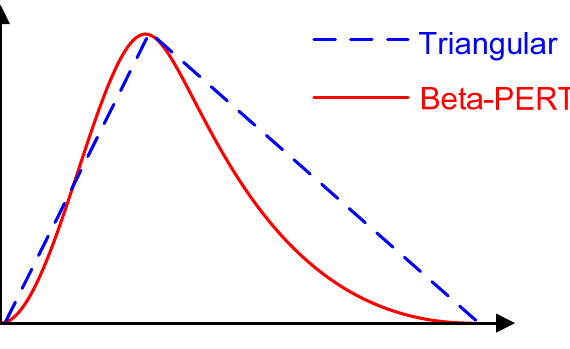
Figure 2. Illustration of the PERT distribution compared with a triangular distribution with the same input